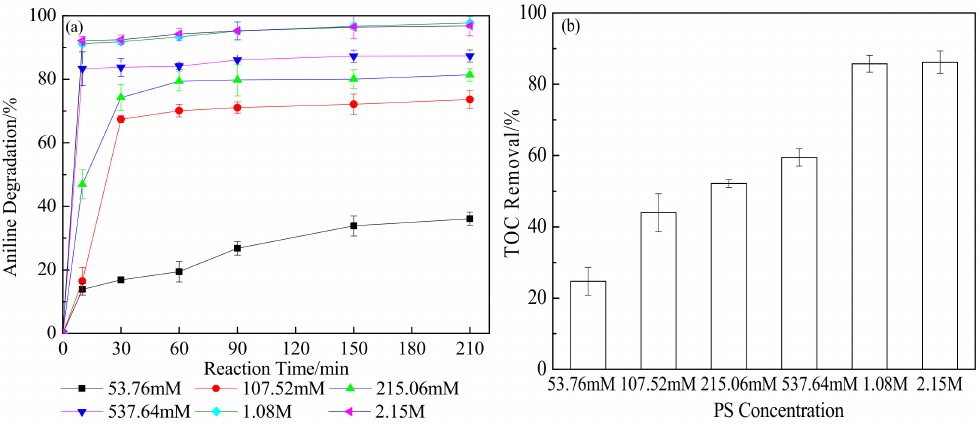
Figure 1. Effects of persulfate (PS) concentration on ( a ) aniline oxidative degradation and ( b ) total organic carbon (TOC) removal (reaction time: 210 min) in soil contaminated with only